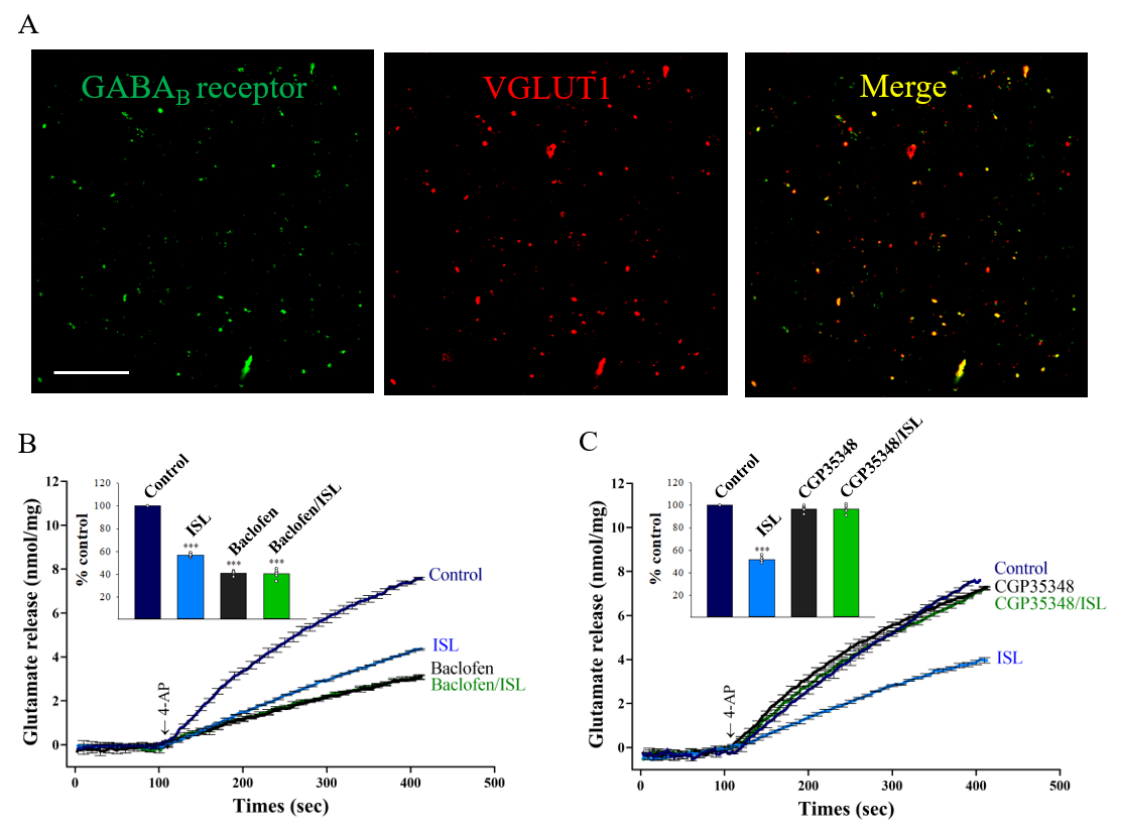
Figure 4. Presynaptic GABA B receptors mediate ISL effects on glutamate release. ( A ) GABA B receptor α1 subunits are present in VGLUT1 positive synaptosomal particles. Confocal microscopy unveiled a significant colocalization of VGLUT1 (red) and GABA B receptor α1 subunit (green) immunopositivities (yellow, merge, arrowhead). Scale bar: 100 μm. 4 -AP- evoked glutamate release from synaptosomes incubated in the absence (control) or presence of 10 µM ISL, 50 µM baclofen, or both ( B ); or 10 µ M ISL, 100 µ M CGP35348, or both ( C ). Insets compare the effects of GABA B receptor agonist or antagonist on 4-AP-evoked glutamate release, or the inhibition by ISL (% control release 5 min after 4-AP addition). Data are the mean ± SEM (n = 5 per group). ***, p < 0.001 versus the control